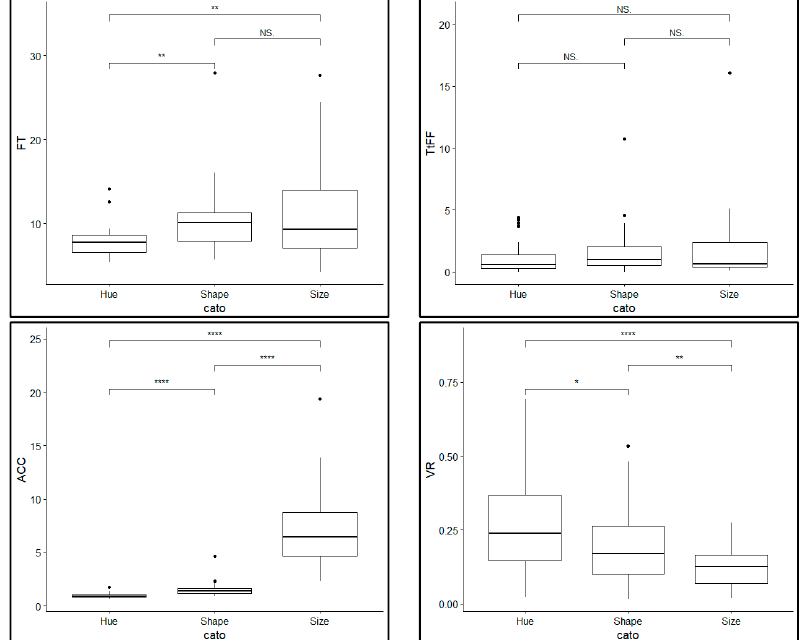
Figure 5. Statistics and significance testing results of the guidance tasks (Exp. 1, mean values of all participants; * p < 0.05, ** p < 0.01, **** p = 0.000, NS = Not significant).